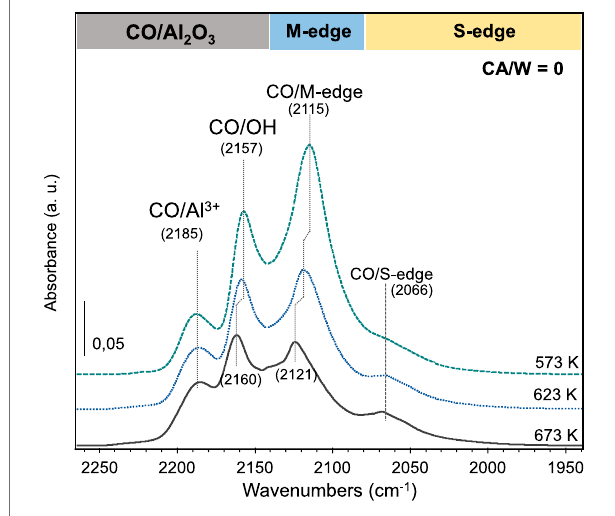
FIGURE7| IRspectraofCOadsorbed(133 Paatequilibrium,100 K)on W/Al 2 O 3 catalyst sul fi ded with 10% H 2 S/H 2 at different